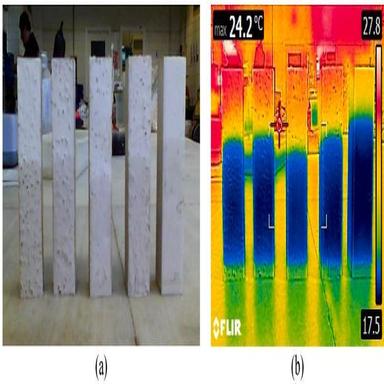
Pictures related to capillarity water absorption: (a) picture of all samples. Left-right: VER; RGW; EC; KPA, E− 0.7; (b) thermography.